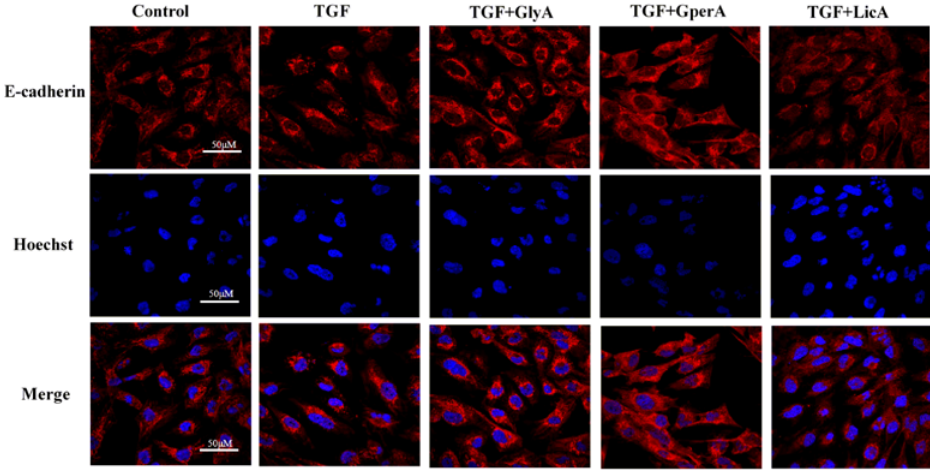
Figure 6. The effect of glycyrrhizic acid (GlyA), glyasperin A (GperA) and licorisoflavan A (LicA) on E-cadherin expression by confocal miscroscopy. Scale bar: 50 μM. n = 12 (single-trial).